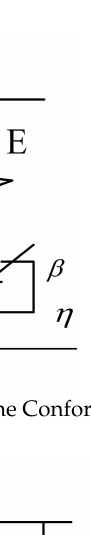
Figure 2. The Kelvin–Voigt model.